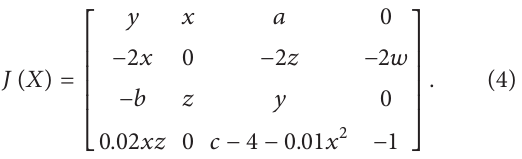
From (3) it can be clearly seen that 𝑎𝑧 2 + 𝑏𝑥 2 = 0 . As 𝑎 > 0 and 𝑏 > 0 the only solution is 𝑥 = 𝑧 = 0 . It can be seen that 𝑐𝑧 − 𝑤 − 𝑤(𝑥)𝑧 = 0 and 𝑥 = 𝑧 = 0 make 𝑤 = 0 ; we conclude that 𝑦 = 0 . Hence system (1) has no equilibrium